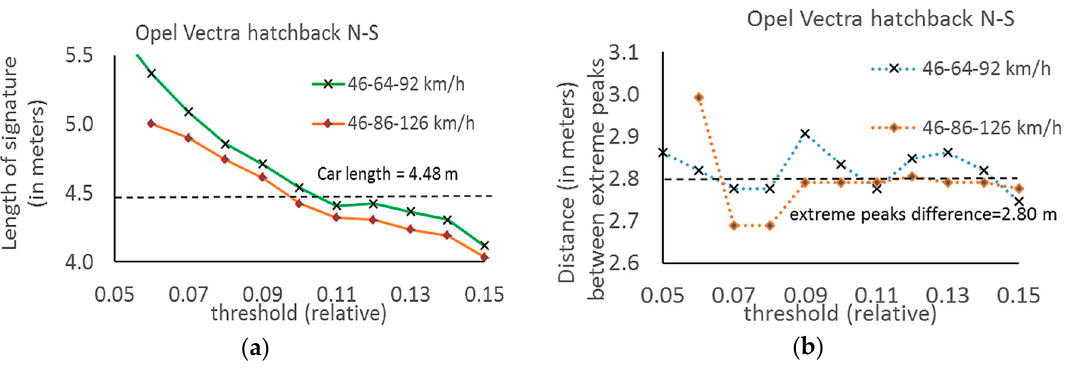
Figure 12. ( a ) Dependence of signature length on threshold—results obtained by means of method 4; ( b ) Dispersion of distance between extreme peaks with changing threshold—results obtained by means of method 4.